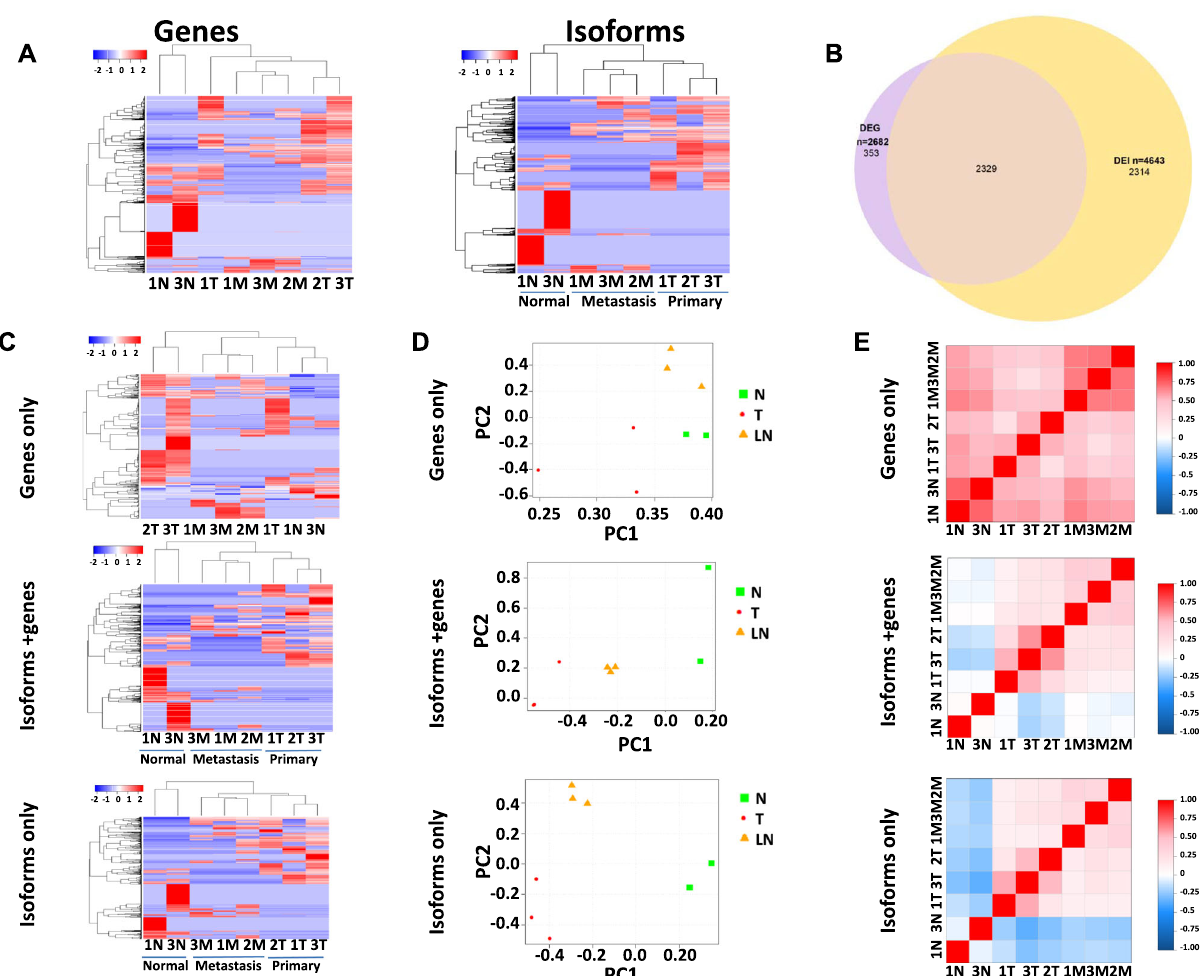
Fig. 2 Tissue segregation by cancer progression stage using isoform-level versus gene-level expression data. A Hierarchical clustering of benign colon samples adjacent to cancer (1 N and 3 N), primary colon cancer samples (1 – 3 T) and metastatic colon cancer samples (1 – 3 M) based on differentially expressed genes (left) or isoforms (right). The color re fl ects the indicated-row Z score. B Venn diagram of overlapping differentially expressed genes and isoforms in colon cancers, metastases, and benign colon tissues adjacent to cancer. C Hierarchical clustering of colon samples based on differential expressed genes but not isoforms (top), or differential expressed genes accompanied with concomitant isoform differential expression (middle), or different isoform expressions without alteration of gene expression (bottom). The color re fl ects the indicated-row Z score. D Principal component analyses of benign colon tissues adjacent to cancer, primary colon cancers, and metastatic colon cancers based on differential gene expression without isoform expression alteration (top), or differential gene expression with concomitant isoform alteration (middle), or differential isoform expression without the alteration of gene expression (bottom). E Pearson ’ s correlation of benign colon tissues adjacent to cancer, primary colon cancers, and metastatic colon cancers based on differential gene expression without isoform expression alteration (top), or differential gene expression with concomitant isoform alteration (middle), or differential isoform expression without the alteration of gene expression (bottom). The color re fl ects Pearson ’ s correlation coef fi cient for the pairing